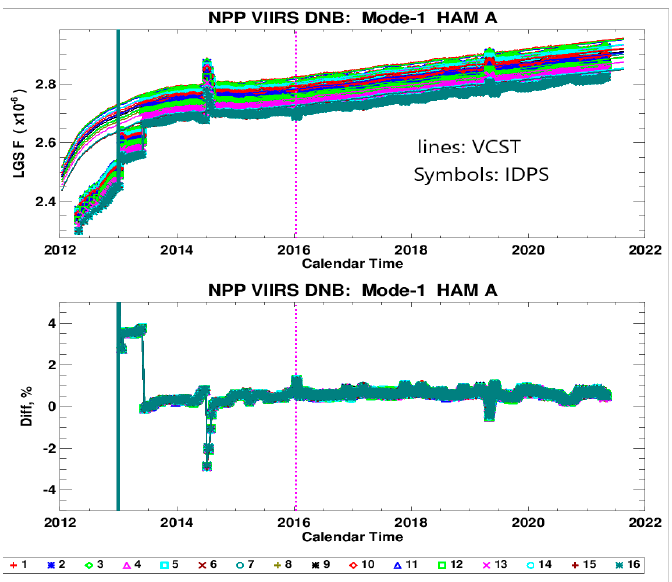
Figure 13. VCST and IDPS SNPP DNB F-factor comparisons in the case of LGS mode-1 at HAM-1. DNB 16 detectors are plotted in different symbols/colors.